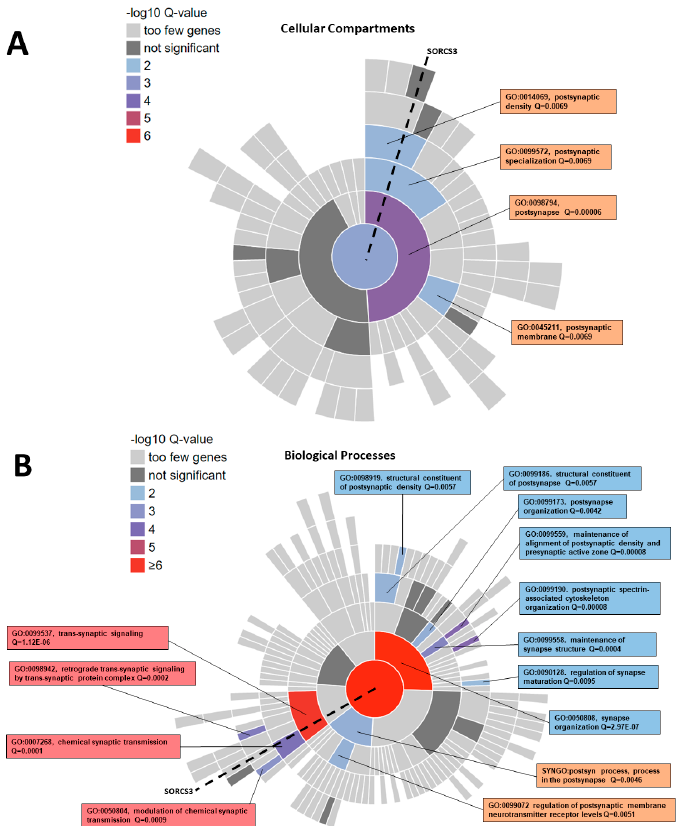
Figure 4. SynGO enrichment of the SORCS3 gene-set. The central circle in the sunburst plot includes all SynGO annotated genes, which then subdivides based on the hierarchy of annotation terms. The dashed line runs through the SynGO terms that contain SORCS3. ( A ) Five Cellular Component terms are significantly enriched at 1% FDR (testing terms with at least three matching input genes), and these terms are in the postsynapse. ( B ) Fifteen Biological Processes terms are significantly enriched, and these terms are in synapse organisation (blue terms), postsynaptic processes (orange terms) and synaptic signalling (red terms).